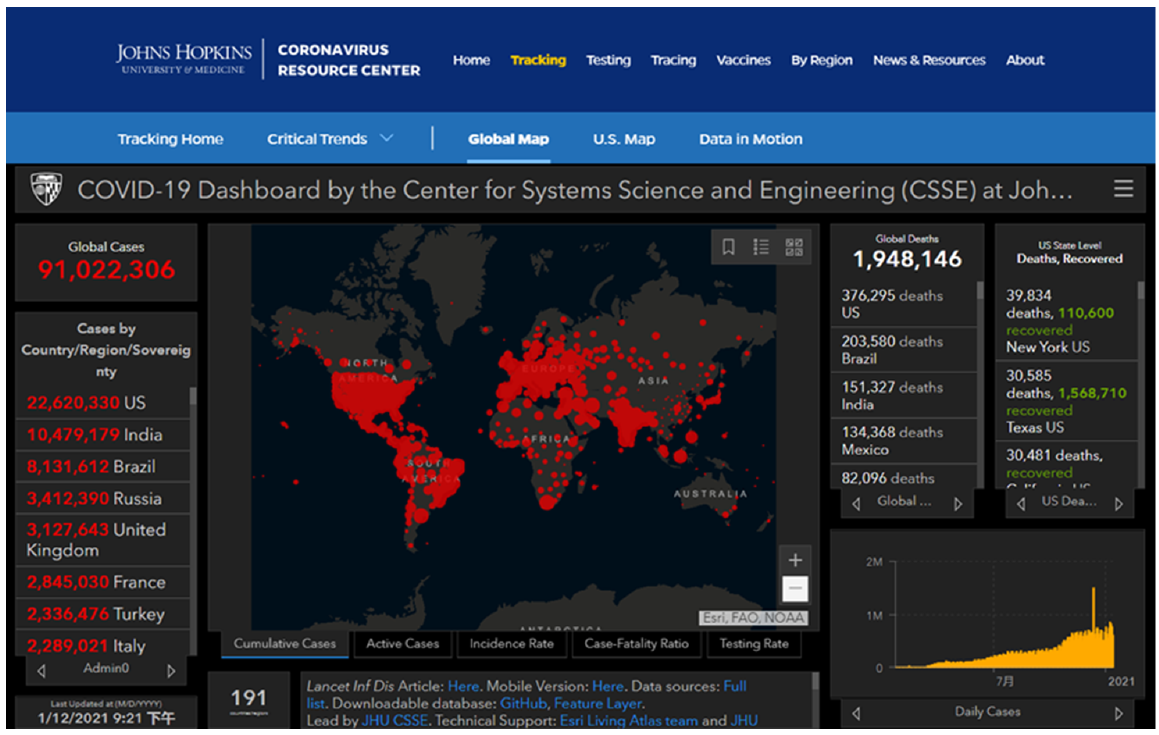
Figure 18. Global map of COVID-19 cases on January 12, 2021. [240].